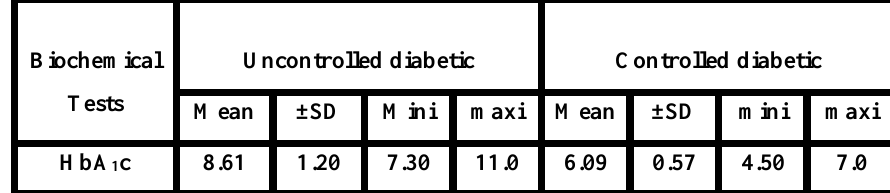
Table (2): Correlations coefficients between HbA controlled diabetic